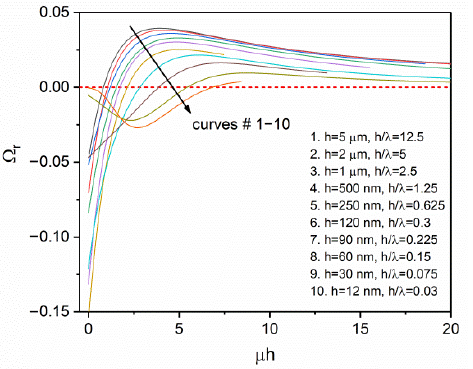
Figure 9. Dependences of the reduced moment of intensity Ω r (Equation (19)) on the parameter of light absorption in a crystal μ h for crystals of different thicknesses ( λ = 400 nm).